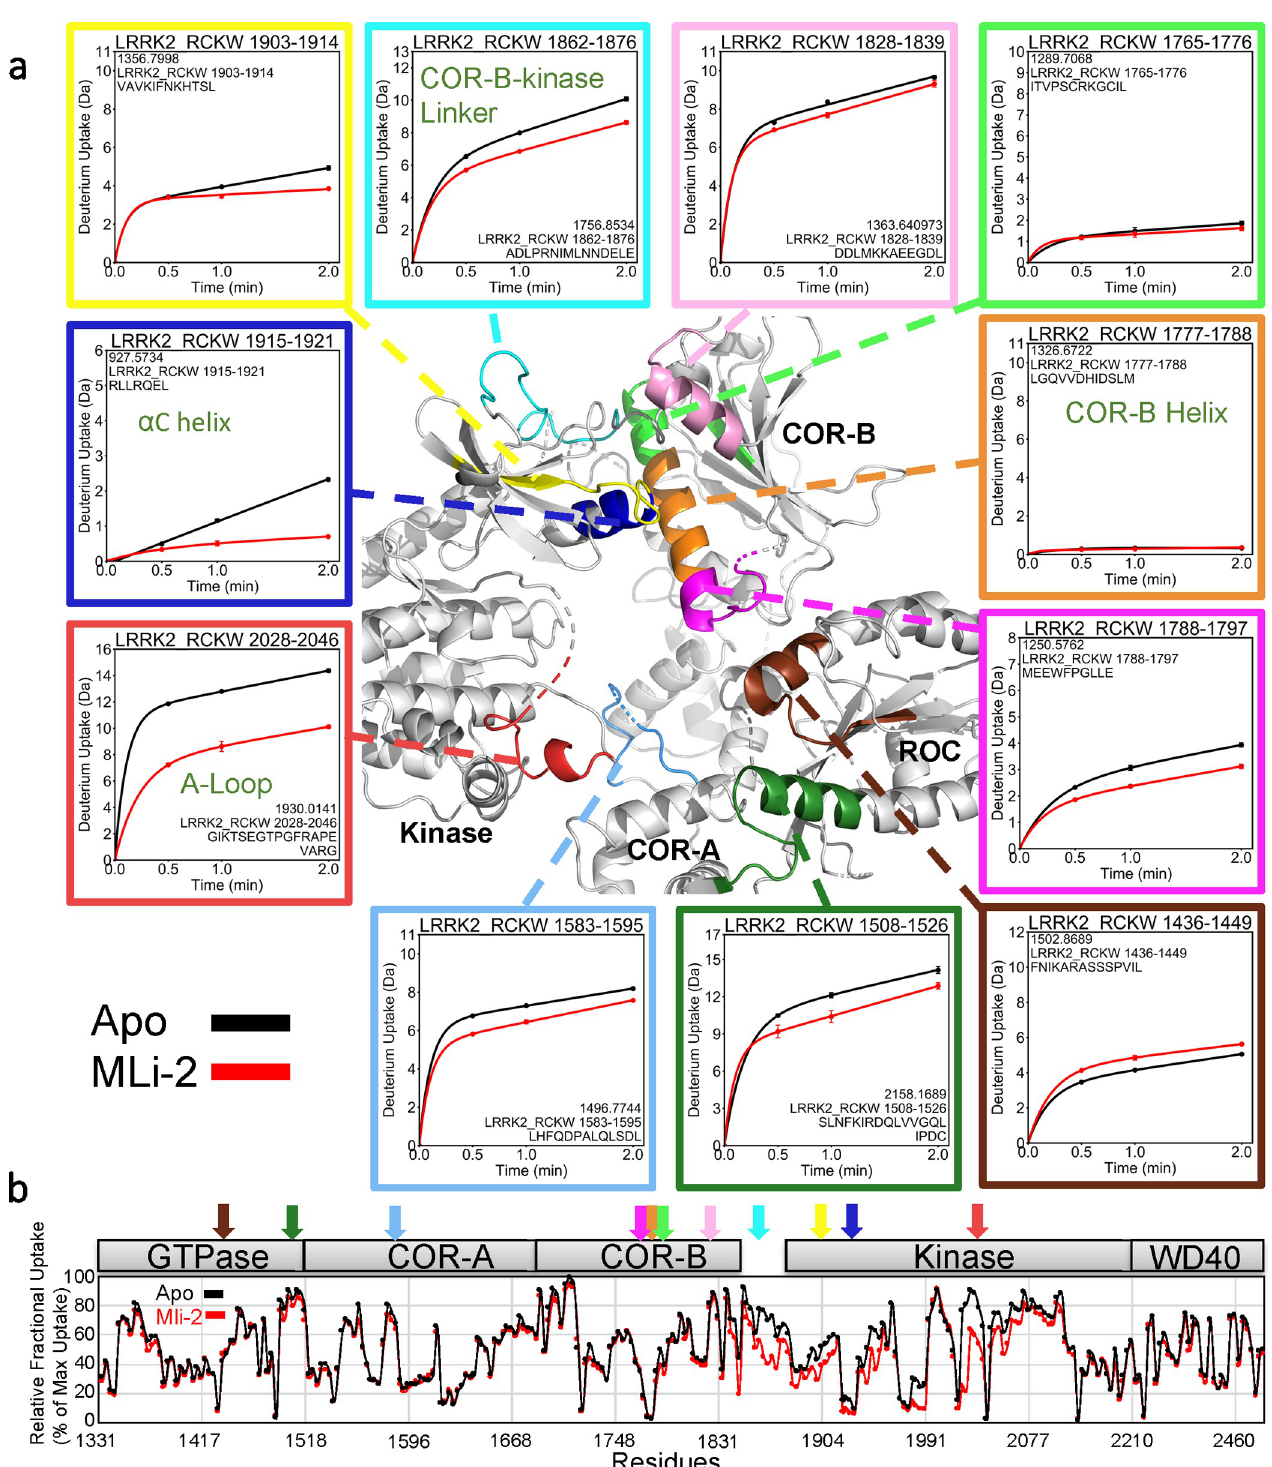
Fig 2. Deuterium uptake around the COR-B Helix. (a) The deuterium uptake of selected peptides is plotted and mapped on the LRRK2 RCKW structure (PDB: 6VNO). The charts are color coded to the corresponding regions shown. The middle of the COR-B Helix has almost no deuterium uptake, suggesting that it is shielded from the solvent. Other peptides that are located at the surface and the A-loop all demonstrate high deuterium uptake. Binding of MLi-2 reduces the deuterium uptake of COR-B-Kinase linker, the α C helix, and the A-loop. The uptake is also reduced in peptides that are located around the N-terminal or C- terminal ends of the COR-B Helix. Peptide 1,426–1,449 in the ROC domain is the only peptide that its uptake increases when binding to MLi-2. (b) The relative